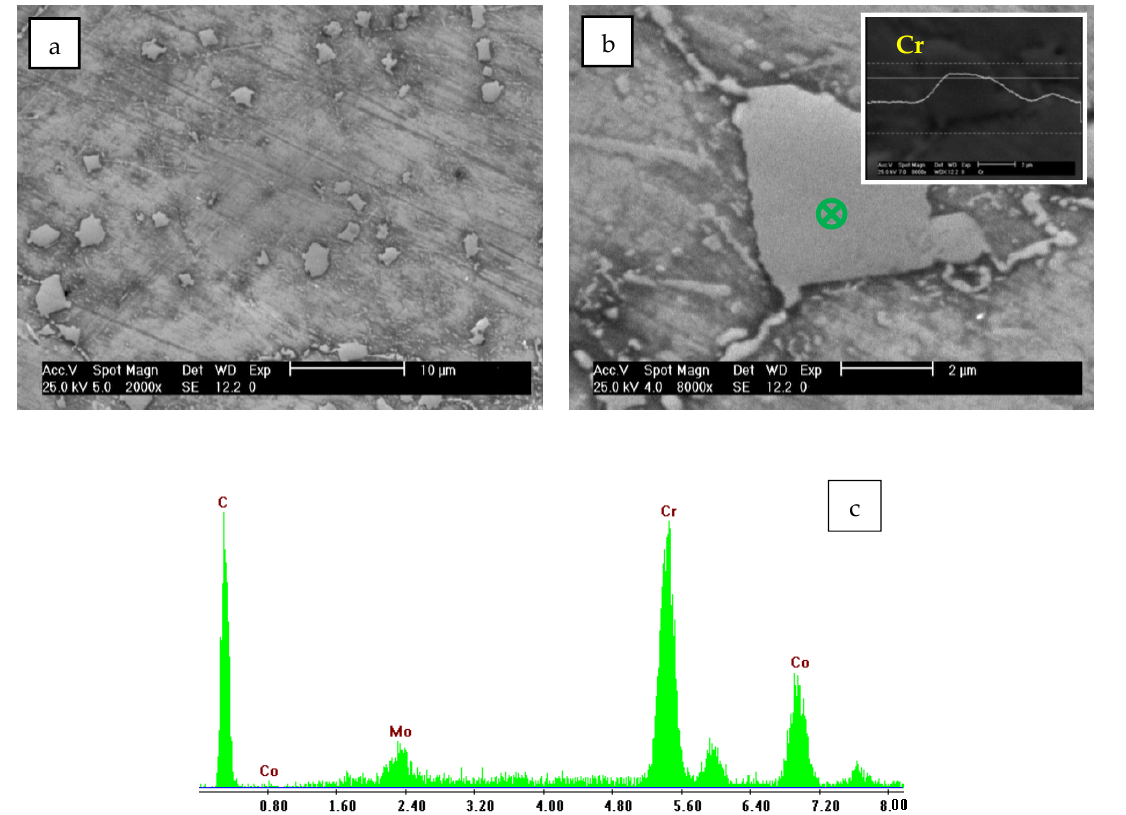
Figure 1. SEM micrographs of ( a ) the partial solution sample and ( b ) undissolved primary carbides. ( c ) EDS point analysis of the precipitated carbide.